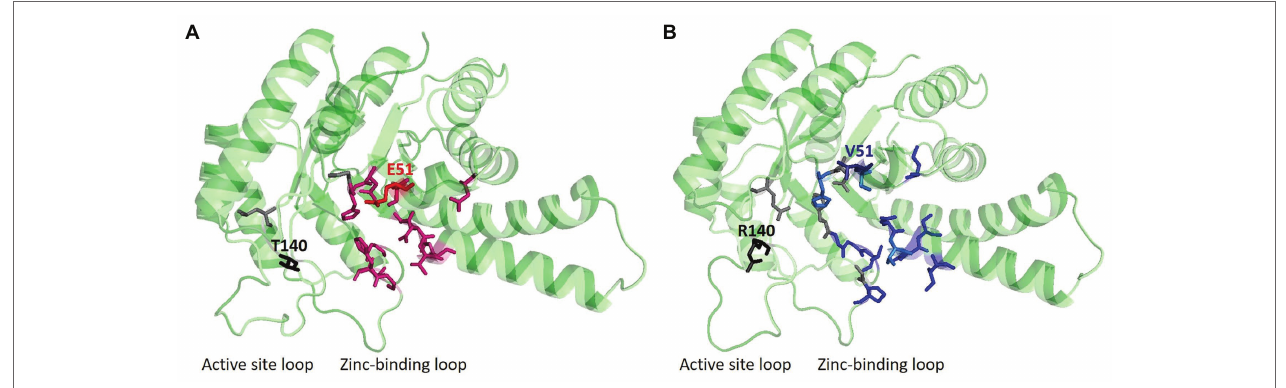
FIGURE 2 | Ligand and structure prediction of FBA C and FBA P . (A) 3D model of the FBA C showing the protein structure, which was depicted with PyMOL (DeLano, 2002), and predicted ligands via COACH-D (Wu et al., 2018b) analysis. (B) 3D protein model of FBA P . In gray, residues that are important for the zinc-binding are shown; while in red residues that are necessary for binding the substrate FBP are plotted. Blue residues are representing important sites for GAP or DHAP interaction. Sites for SDM are marked in the 3D structures of the protein models (E51V, T140R). The 3D structure of the protein models indicates typical triosephosphate isomerase (TIM)